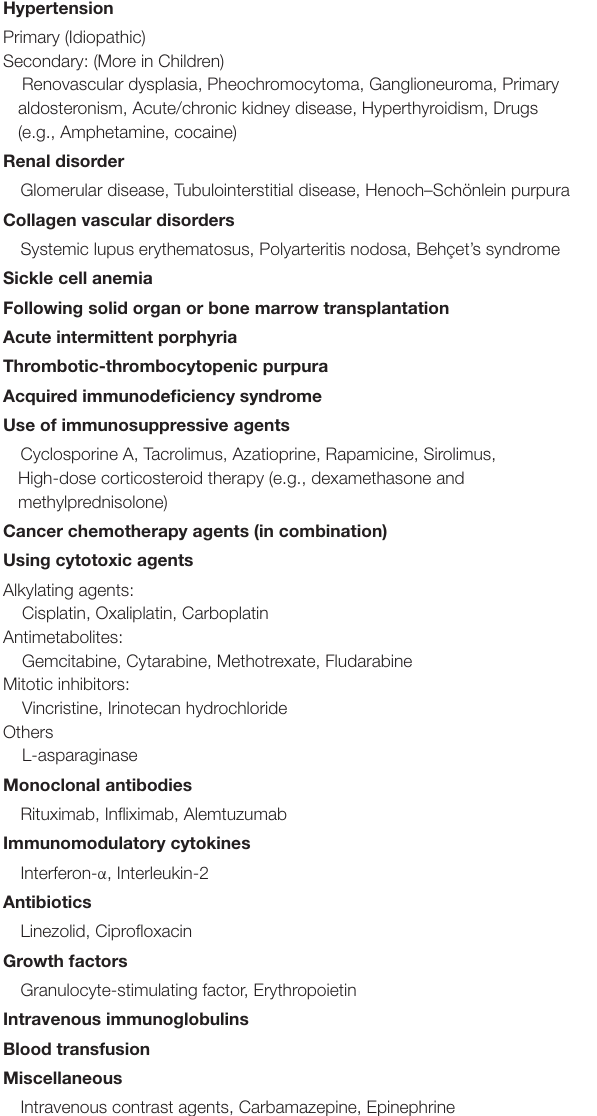
TABLE 1 | Risk factors for posterior reversible encephalopathy syndrome in children.